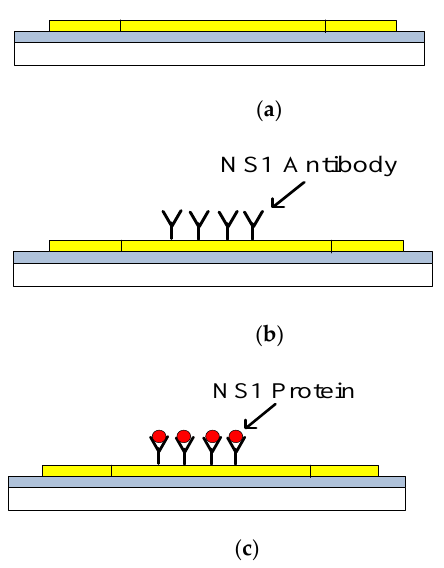
Figure 6. Three phases of characterisation samples; ( a ) Phase I: Free sensor surface; ( b ) Phase II: Functionalised sensing area with antibody; ( c ) Phase III: Sensor surface with antibody-antigen complex formation.